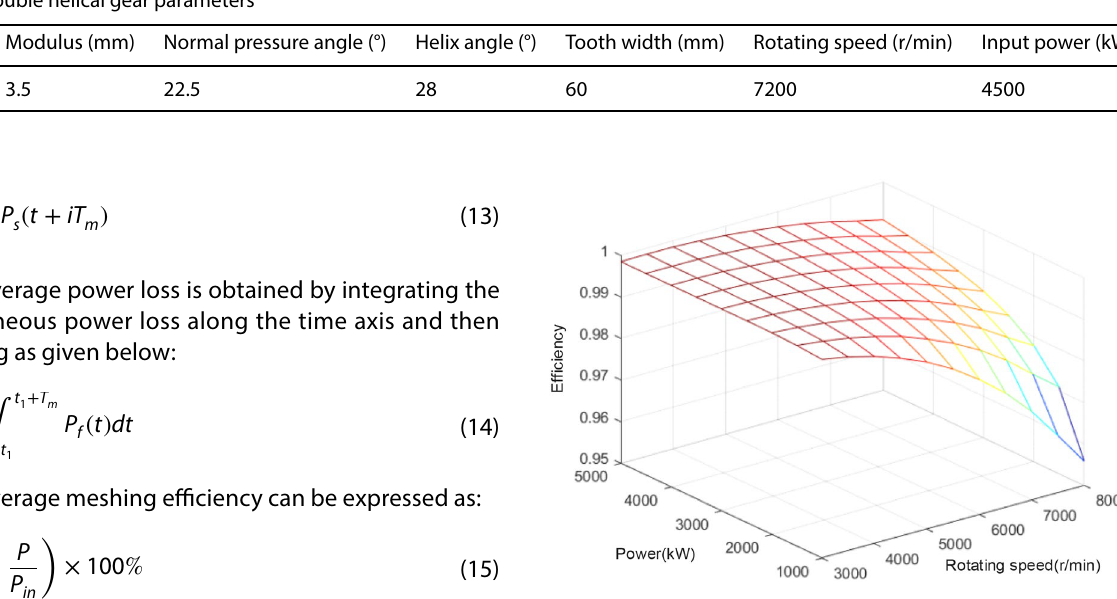
Fig. 2 Efficiency at different input power and speed